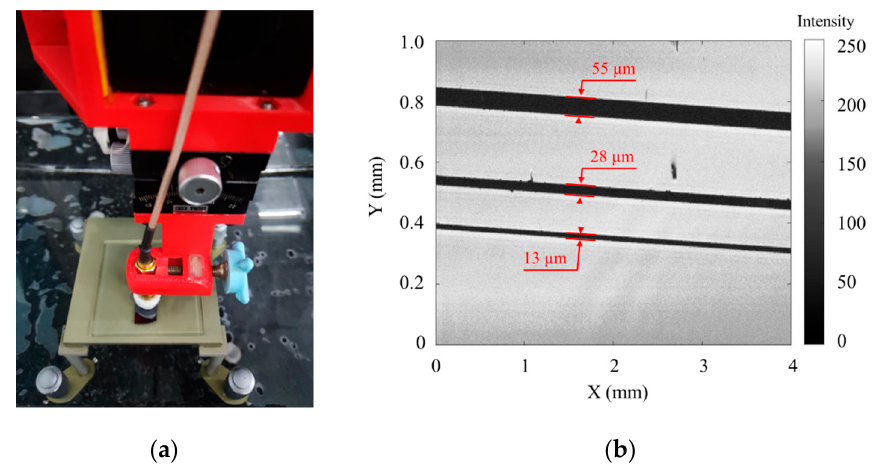
Figure 8. ( a ) Silicon wafer imaging testing. ( b ) The ultrasonic image of slots on silicon wafer.